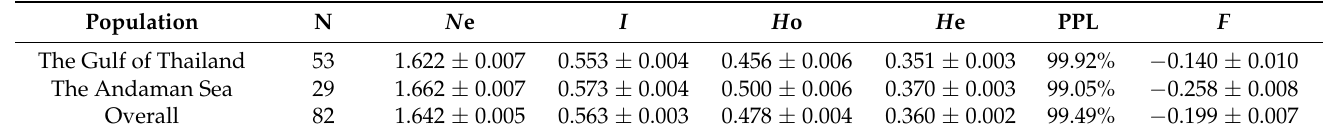
Table 1. Genetic diversity parameters of two genetic clusters of 82 R. apiculata accessions in Thailand based on 2640 SNPs.